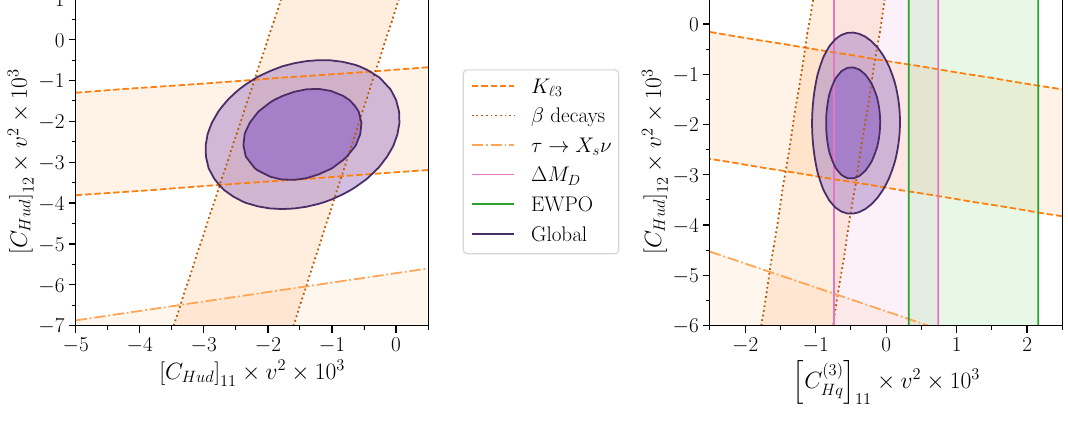
Figure 6 . Preferred regions for our two 2-D scenarios, see main text for